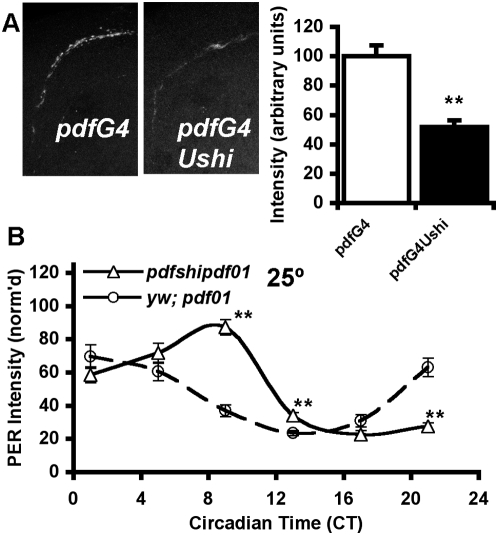

shibirets1 effects on PER rhythms are independent of PDF.A) shibirets1 reduces PDF levels. PDF levels were measured in sLNv terminals of the dorsal protocerebrum on DD3 (25°C). Overall PDF levels were lower in pdfGAL4/+; Ushits1/+ (**p<0.05, see methods). B) On DD3 (25°C), sLNv PER was relatively normal in y w; pdf01 flies. shits1 expression in the absence of PDF (pdfGAL4/+; Ushits1- pdf01/ pdf01) results in PER delays similar to PDF+ flies (*p<0.01, **p<0.05).